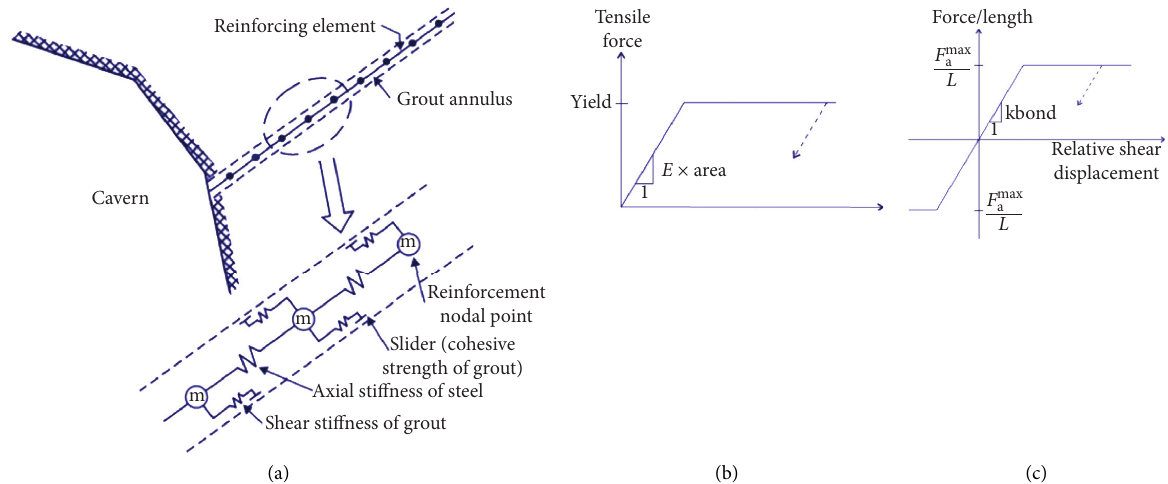
Figure 8: Conceptual mechanical representation of fully bonded reinforcement, which accounts for shear behavior of the grout annulus (a). Cable material behavior for cable elements (b). Grout material behavior for cable elements (c).